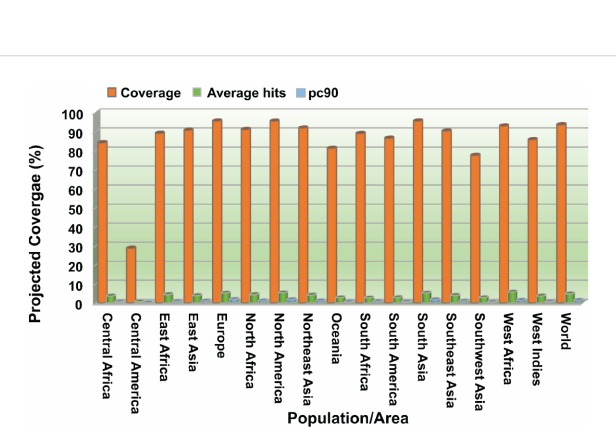
FIGURE 3 Population coverage analysis of combined CTL and HTL epitopes worldwide and across different regions. Coverage, projected population coverage; pc90, the minimum count of epitope hits/HLA combinations recognized by 90% of the population; Average hit/HLA combination, an average count of epitope hits/HLA combinations recognized by the